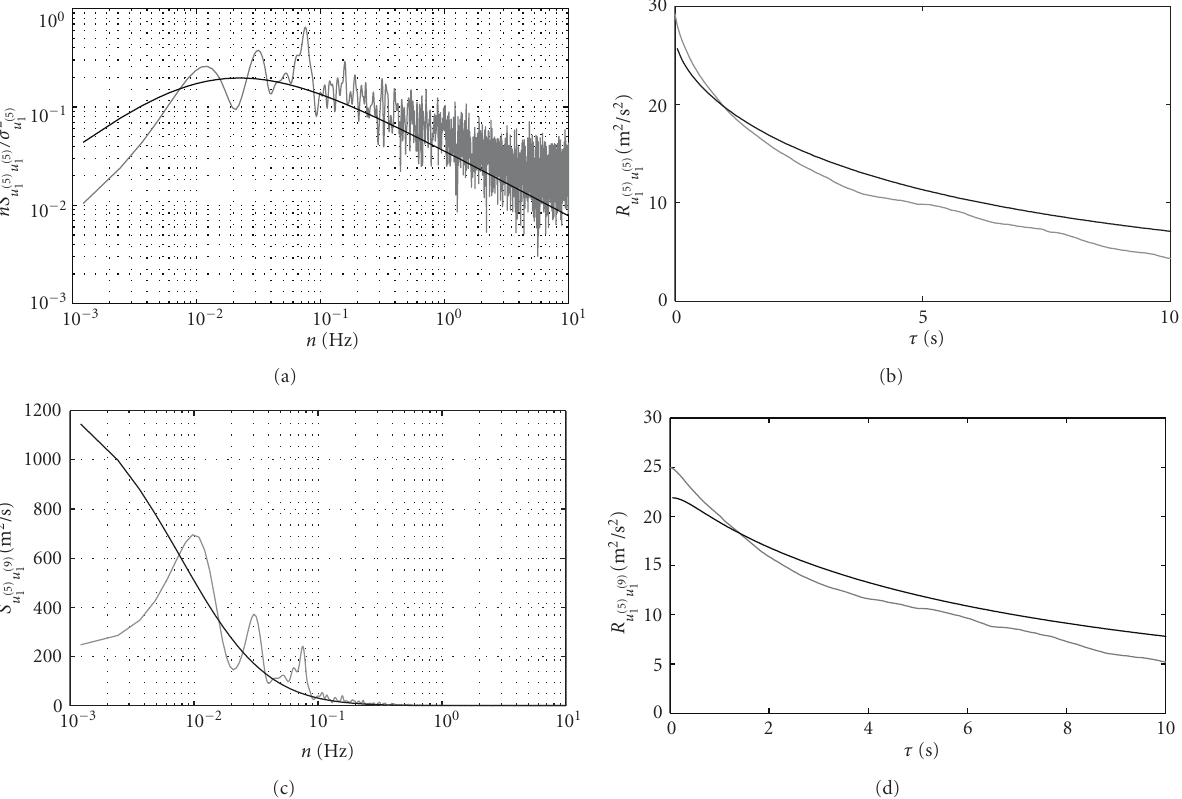
Figure 9: Example 1 using AR method (black lines denote target functions, gray lines denote numeric approximations): autospectrum of along-wind velocity at point 5 (a); corresponding autocorrelation function (b); cross-spectrum between along-wind velocities at points 5 and 9 (c); corresponding cross-correlation function